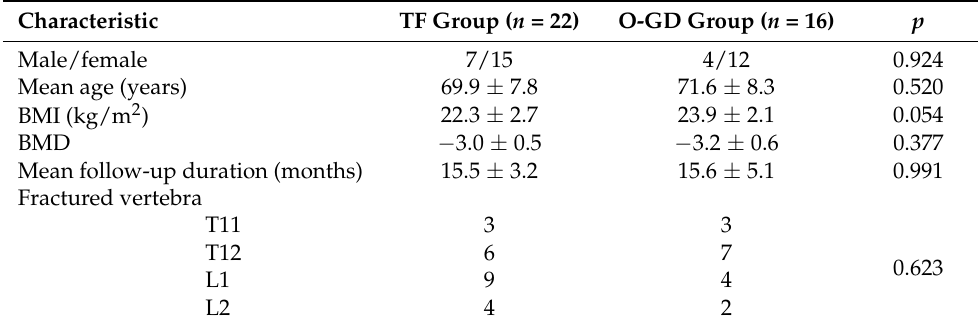
Table 1. Comparison of characteristic parameters between the 2 groups.